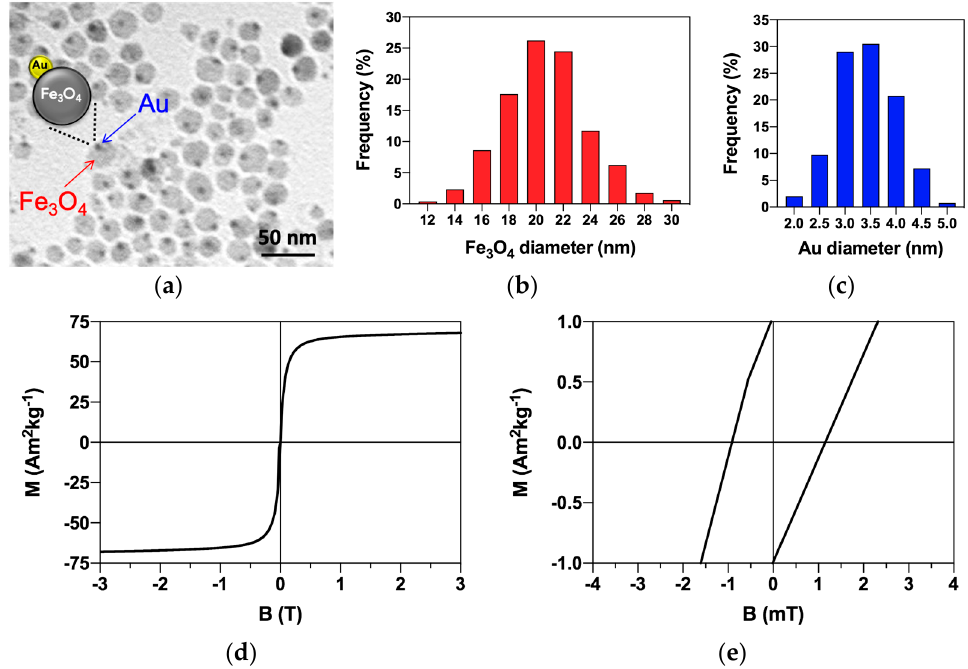
Figure 1. Magnetite–gold dumbbell nanoparticle characterization. ( a ) TEM micrograph of investi- gated MNPs-Cy5 with the schematical representation of the nanoparticle structure; ( b ) Histogram of magnetite size distribution obtained from the analysis of TEM micrographs; ( c ) Histogram of gold size distribution obtained from the analysis of TEM micrographs; ( d ) Hysteresis loop of MNPs at 300 K, VSM; ( e ) Close-up of a hysteresis loop demonstrating a coercive field of MNPs at 300 K. To visualize the behavior and a real-time movement of MNPs-Cy5 in water solution (used for all in vitro experiments) under a low-frequency magnetic field, they were placed into a magneto-optic system. Chaotically located MNP conglomerates with a size ≤ 1 µ